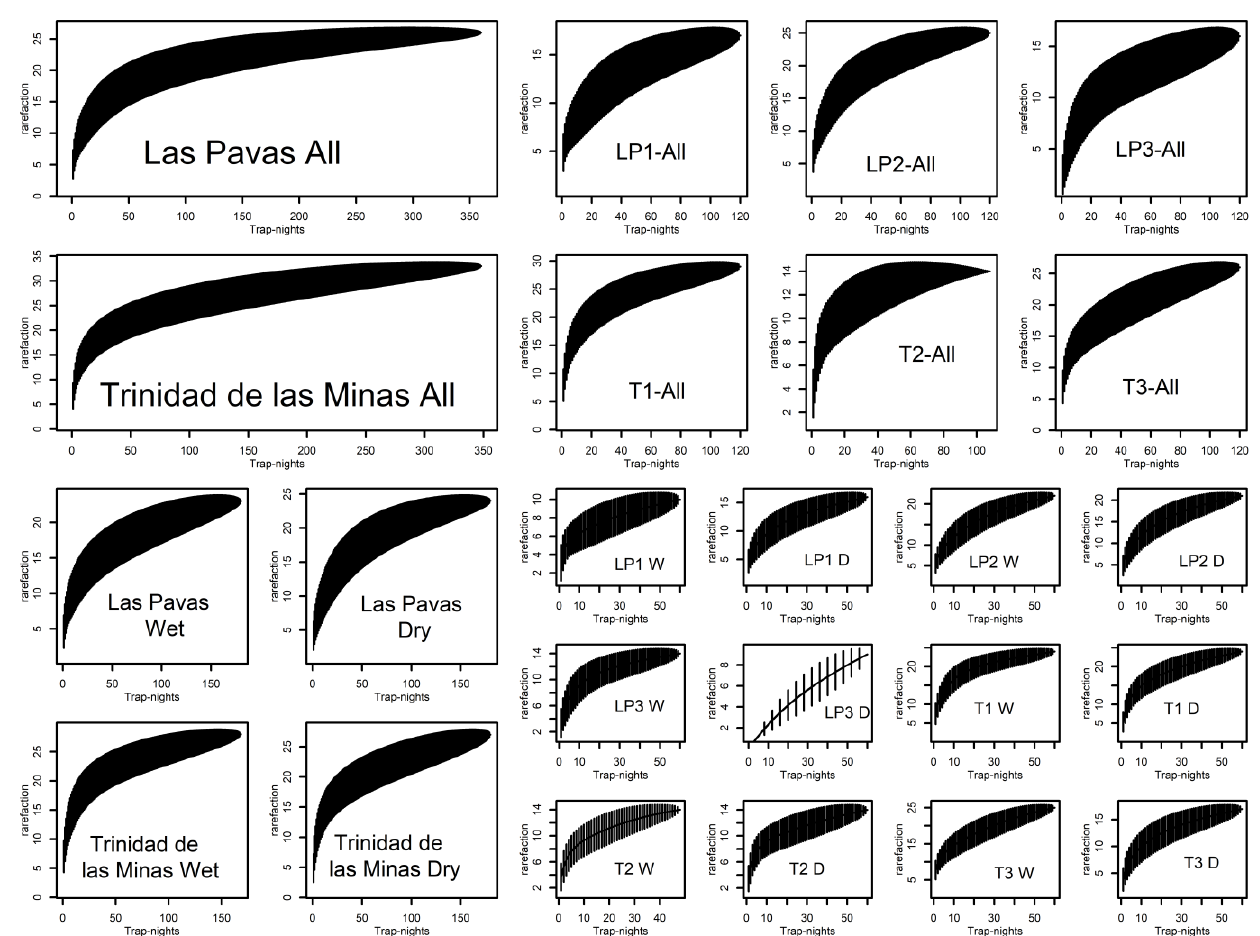
Figure 2. Species’ accumulation curves of the total number of sand fly species collected in the two study communities Las Pavas (LP) and Trinidad de las Minas (T) through the study period (All); and three plots from each community through the study period (LP1-peridomicile-All, LP2-partly wooded-All, LP3-wooded-All and T1-wooded-All, T2-peridomicile-All, T3-partly wooded-All); in LP and T during the Wet and Dry seasons; in each plot from each community during the wet (W) and dry (D) seasons.